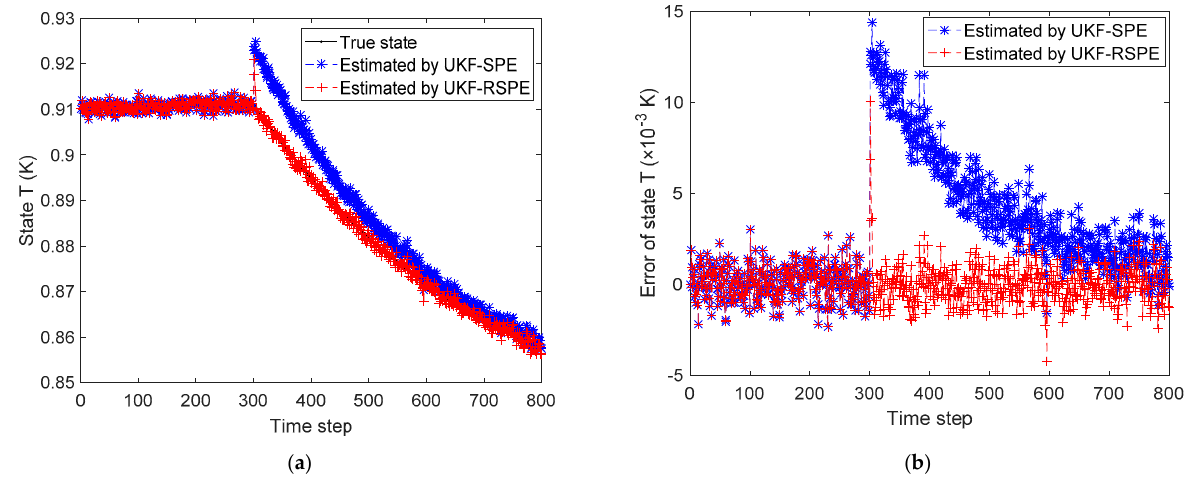
Figure 12. The comparison of the estimated results of the state (cid:101) T k in Case Study 2.2: ( a ) estimated state; ( b ) state error.